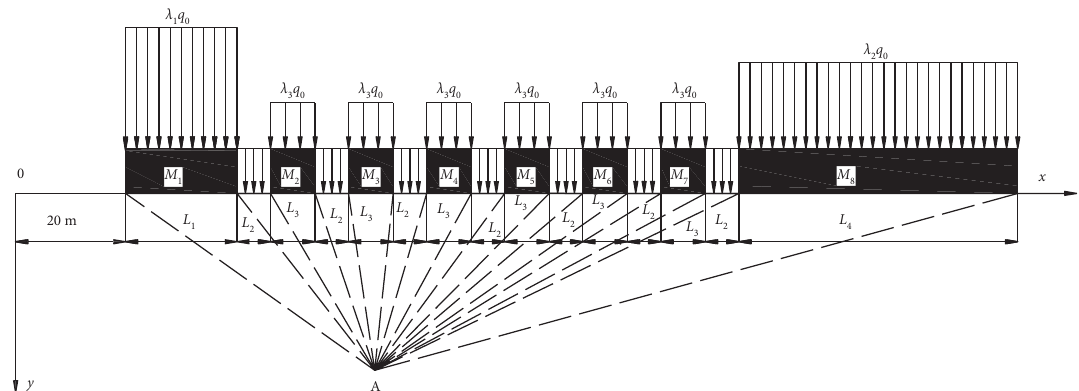
Figure 2: Loading model of the floor rock strata of the coal seam 2 − 2